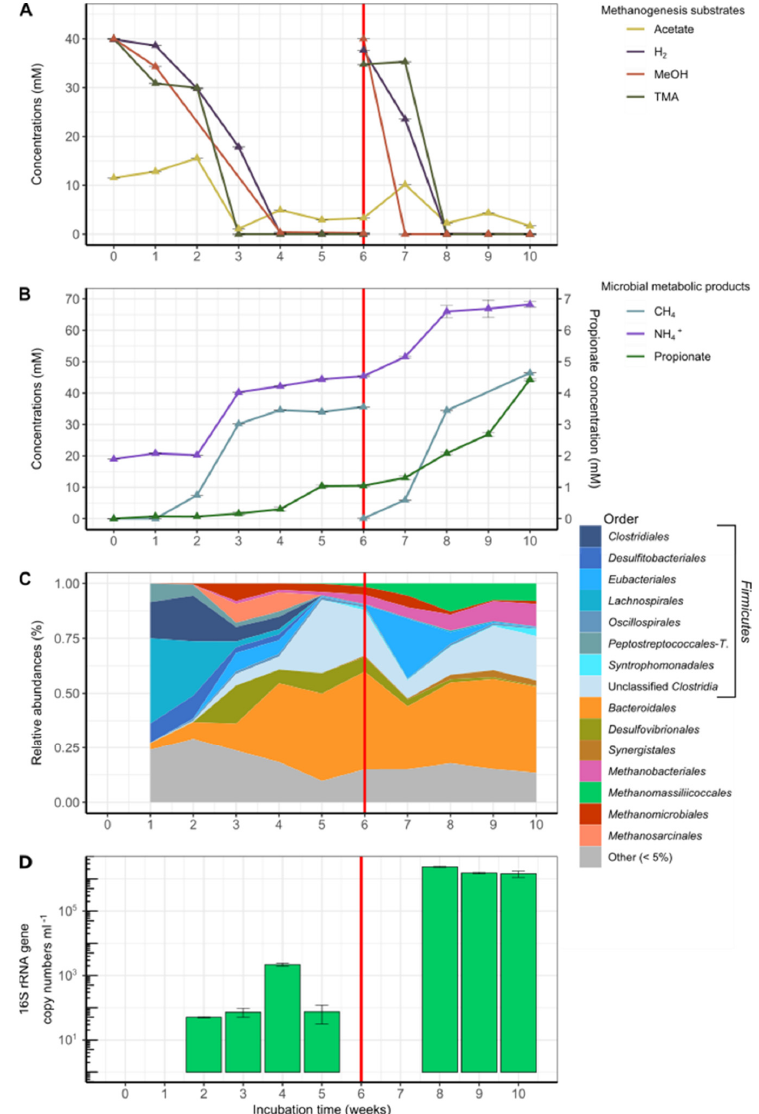
Figure 3. ( A ) Consumption kinetics of methanogenesis substrates during the weeks of incubation of the substrate-amended slurry performed with the PENF sample; ( B ) Consumption kinetics of some metabolic products (methane, ammonia, propionate) during the weeks of incubation of the substrate-amended slurry performed with the PENF sample. Concentrations of propionate are indicated on the right vertical axis of the figure and other microbial products (CH 4 and NH 4+ ) are indicate on the left vertical axis. The vertical red line indicates a novel addition of trimethylamine (TMA), methanol and H 2 /CO 2 at T6 to stimulate methanogenesis; ( C ) Trends in microbial diversity revealed by metabarcoding; ( D ) Methanomassiliicoccales abundances determined by qPCR (logarithmic scale). Methanomassiliicoccales could not be quantified by qPCR in 4 samples (T0, T1, T6, and T7). Average copy numbers are given on the chart bars. Renewal of methanogenesis substrates (H 2 , CO 2 , MeOH, TMA) after six weeks of incubation is represented by the vertical red lines. Peptostreptococcales - T .: Peptostreptococcales-Tissierellales . In terms of overall diversity, the species richness slightly decreased over incubation time (from T1 to T10: Shannon index, 3.11 to 2.61; Simpson index, 0.88 to 0.82) (Figure S2). time ( Bacteroidales , Clostridiales , Desulfovibrionales , and Synergistales ), as well as those